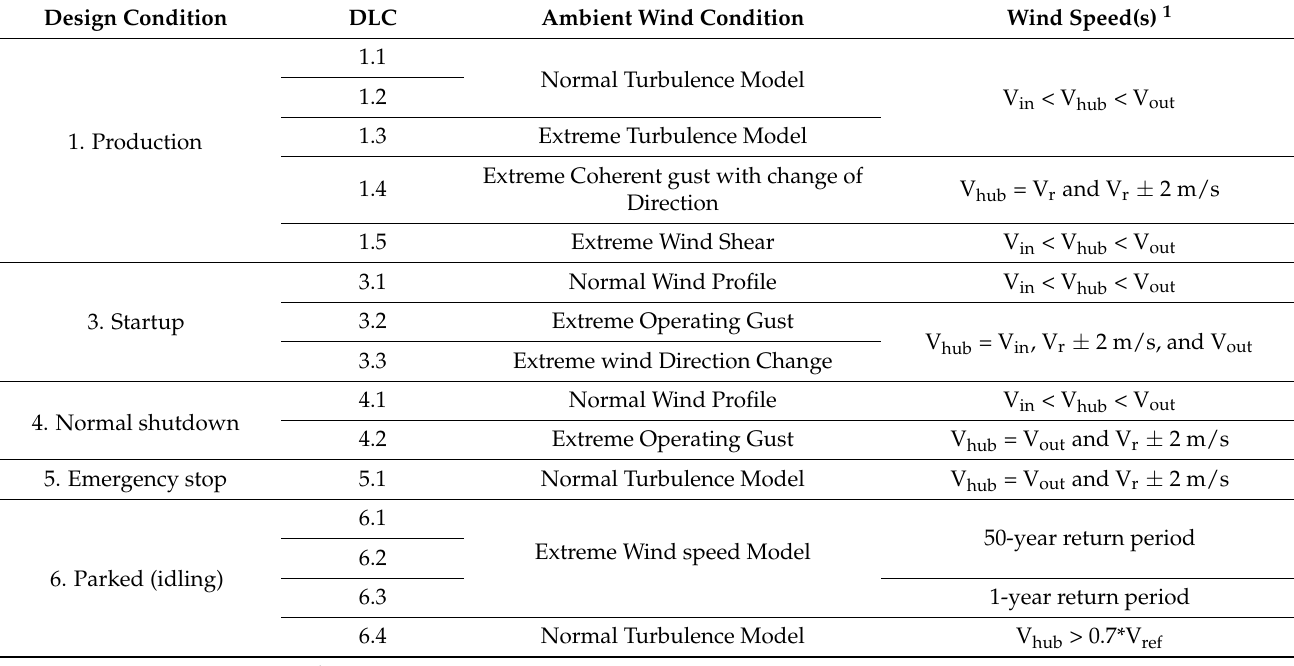
Table 3. Design conditions, design load cases, and implied wind conditions [43].